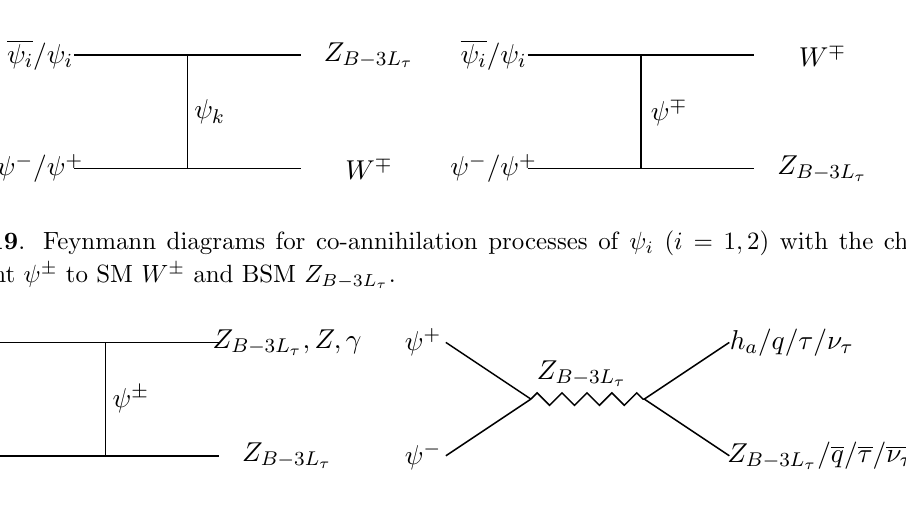
Figure 18 . Additional Feynmann diagrams for DM, i due to presence of new gauged paricle Z B (cid:0) 3 L in the model: annihilation ( i = j ) and Co-annihilation ( i 6 = j ). Here i; j; k = 1 ; 2; a = 1 ; 2 ; 3 (cid:28) and q stand for SM quarks.